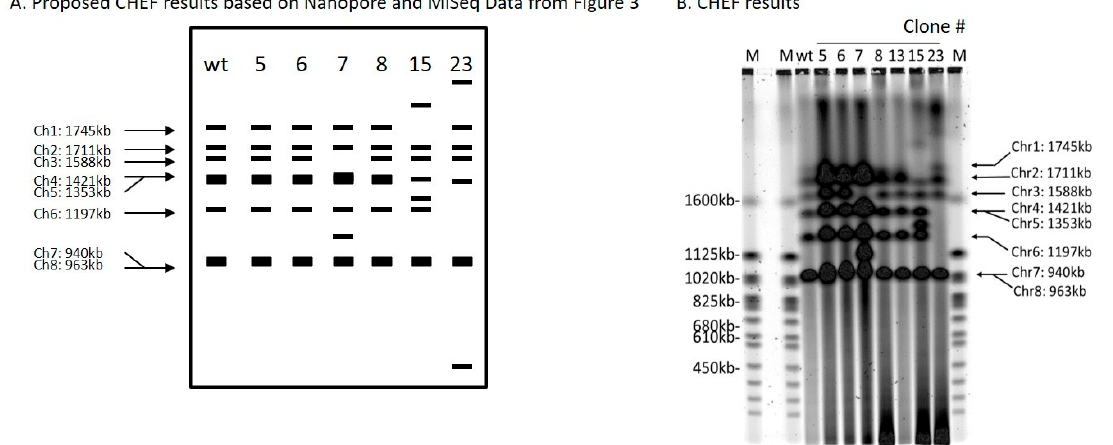
Figure 4. Contour-clamped homogeneous electric field (CHEF) analysis of ScURA3 inversion and deletion as well as translocation events. ( A ). A schematic of expected band patterns of each clone. ( B ). CHEF results of clone 5, 6, 7, 8, 13, 15, and 23.